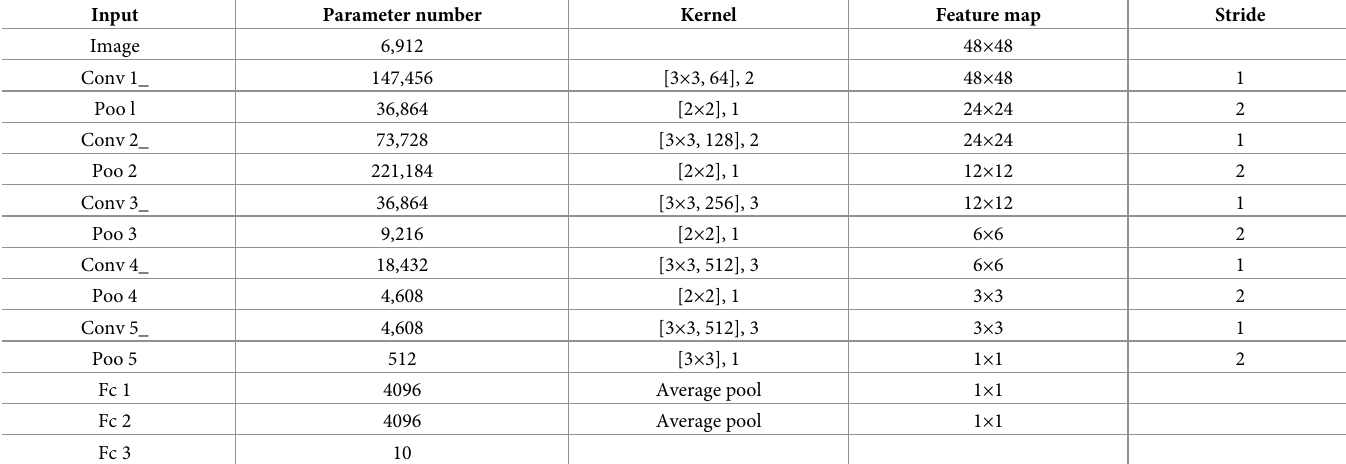
Table 3. Parameter settings of ONet.